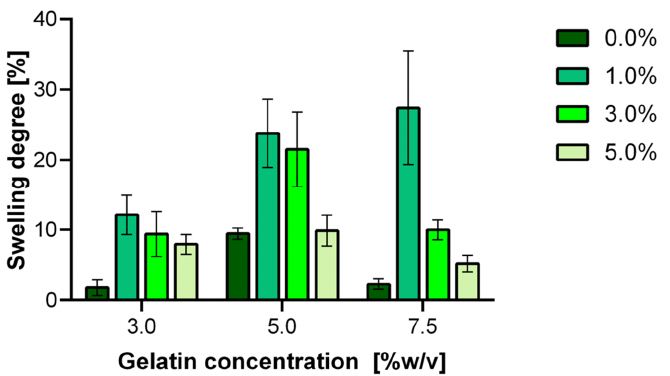
Figure 4. Swelling behavior of hydrogels prepared with varying levels of gelatin and degrees of crosslinking. The experiments were conducted in aqueous solution at pH 7.4 and 37